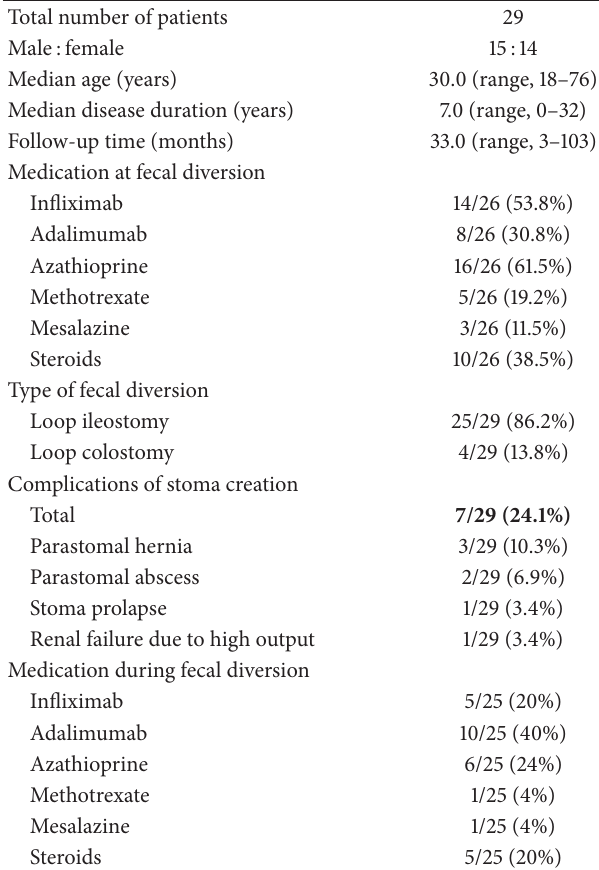
Table 1: Patient characteristics, details of stoma creation, and